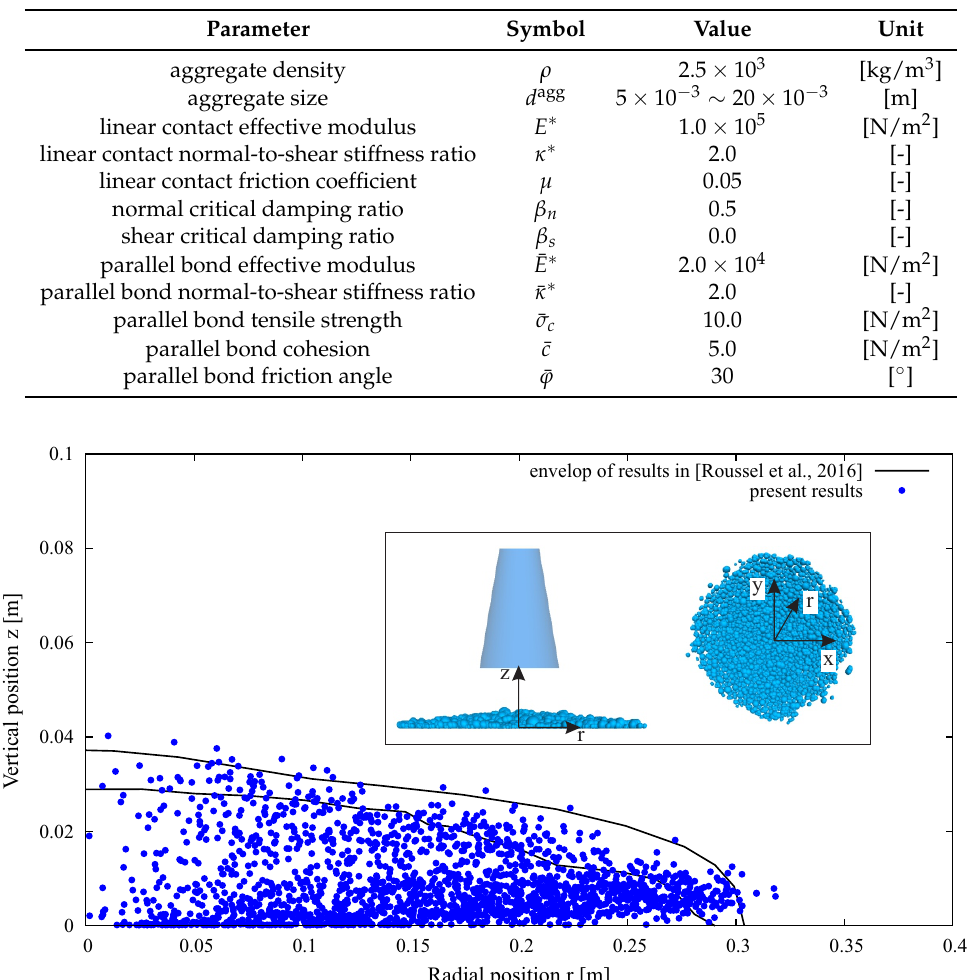
Figure 4. Calibration of DEM model with slump test: comparison between present DEM simulation results (every blue dot indicates the position of a specific aggregate) and the benchmark results in [70].